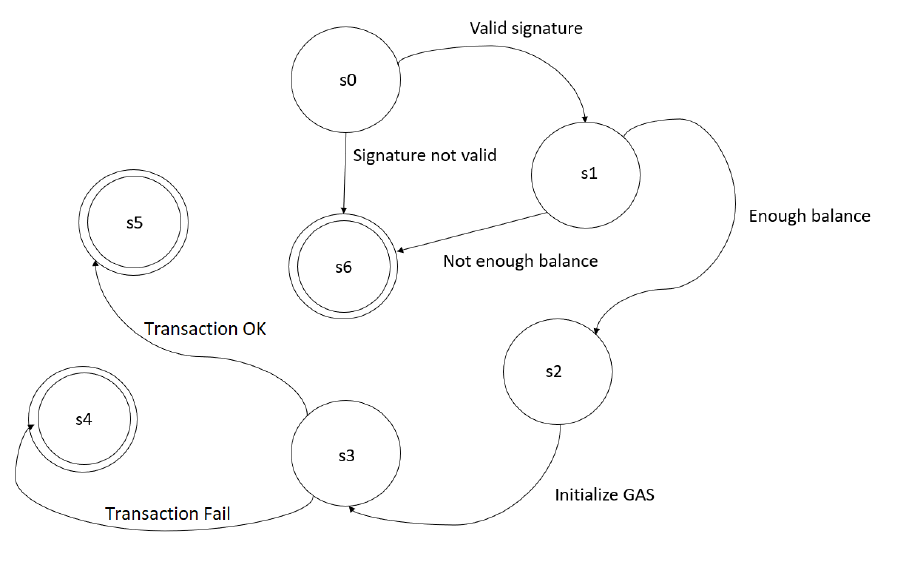
Figure 2. Ethereum state